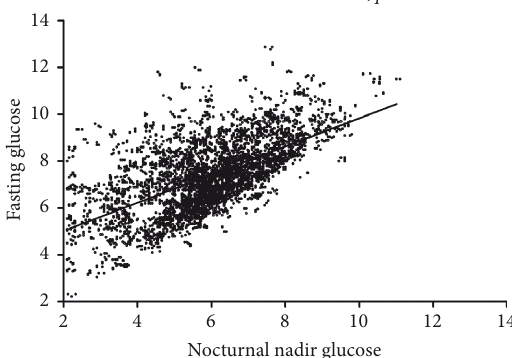
Figure 3: Relationship between nocturnal glucose nadir and morning fasting glucose